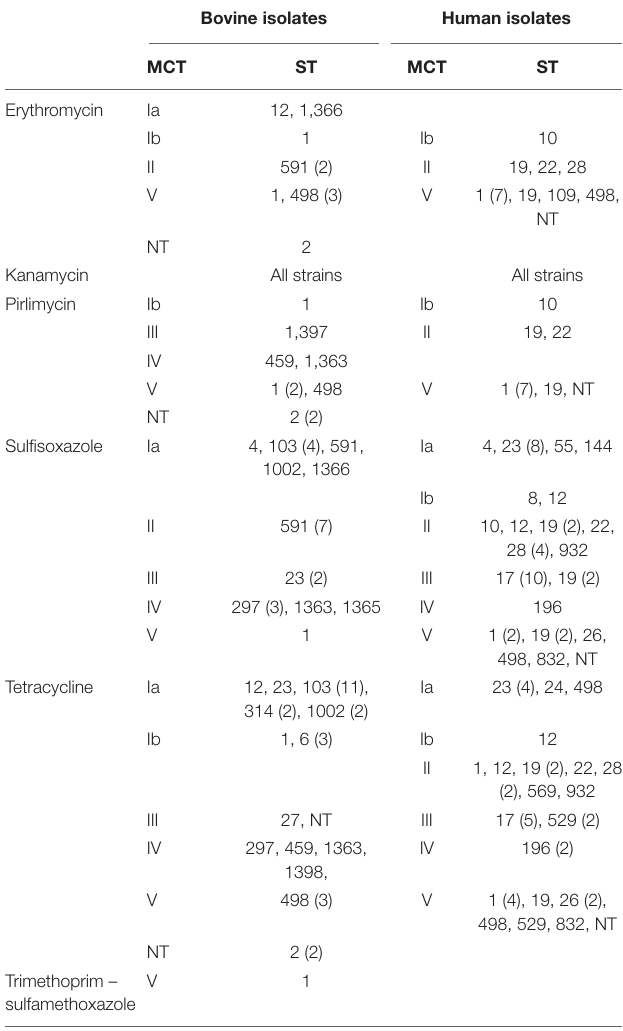
TABLE 4 | Molecular capsular typing and sequence types of the bovine and human resistant isolates. Bovine isolates Human